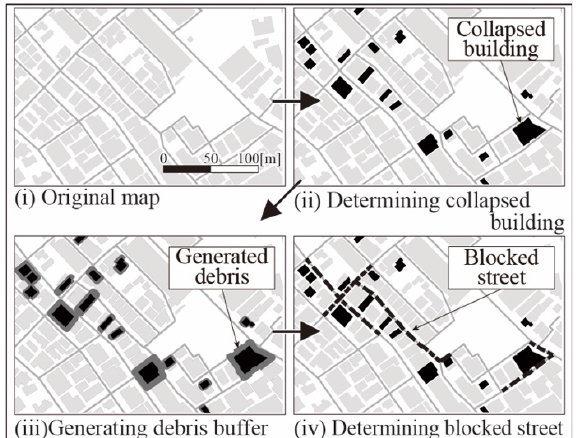
Figure 2. Estimation of property